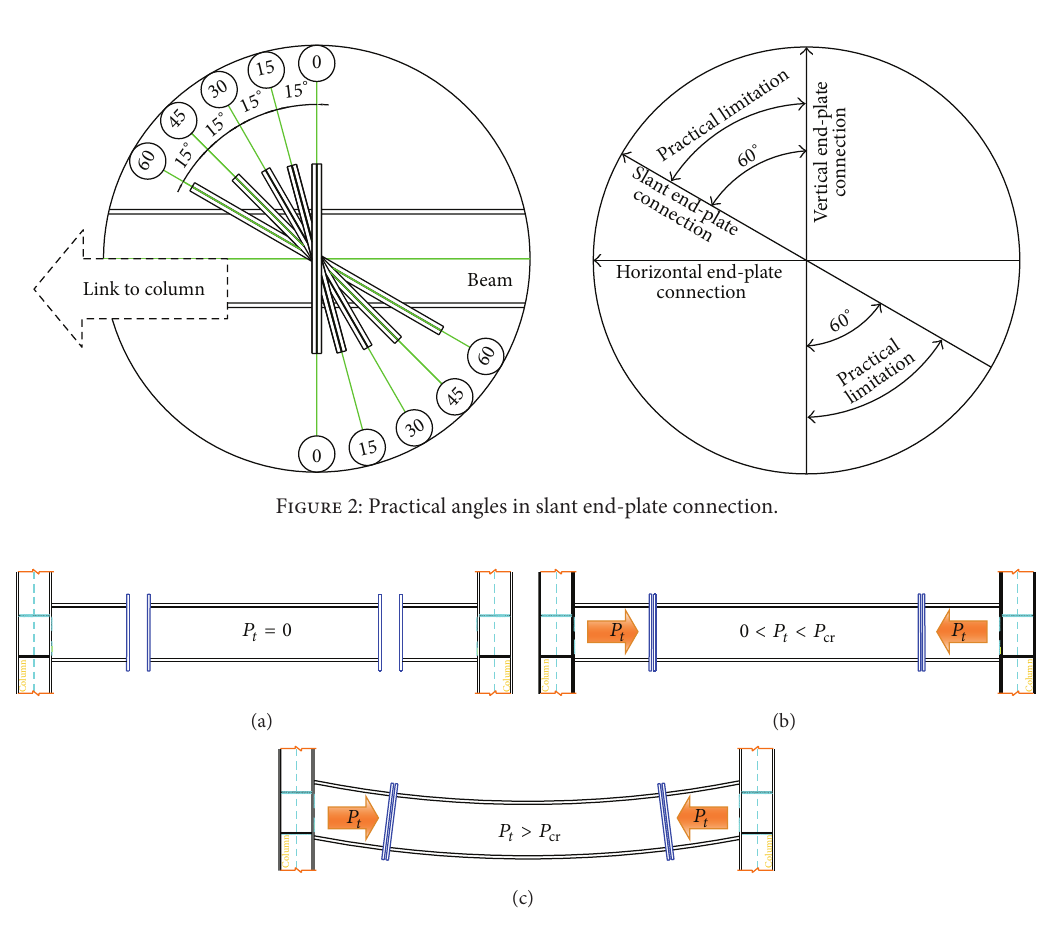
Figure 3: Beam with vertical bolted end-plate connection subjected to temperature increase. (a) Stage 1: beam connections before increasing the temperature. (b) Stage 2: beam connection after increase in temperature “contact two plates together.” (c) Stage 3: beam connection after increase in temperature “buckling and decrease Young’s